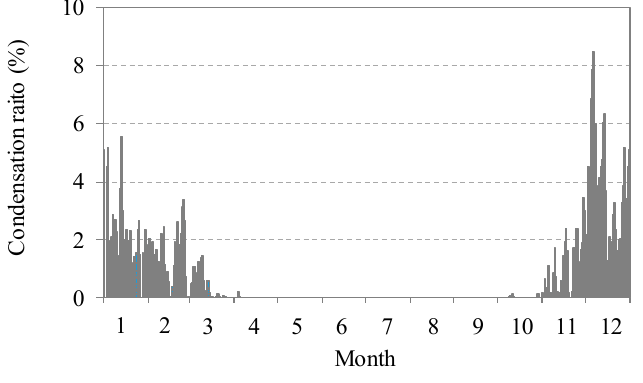
Figure 5. Annual condensation ratio.